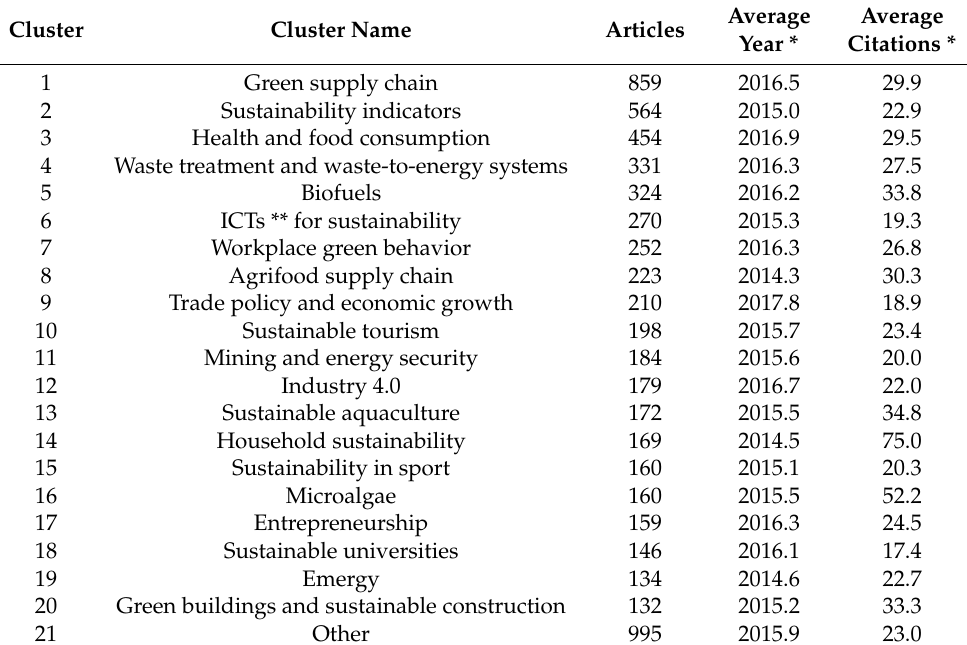
Figure 5. Citation network of environmental sustainability research. Each colored section represents one of the 21 clusters found; the six largest clusters are labeled. Table 2. Clusters of environmental sustainability